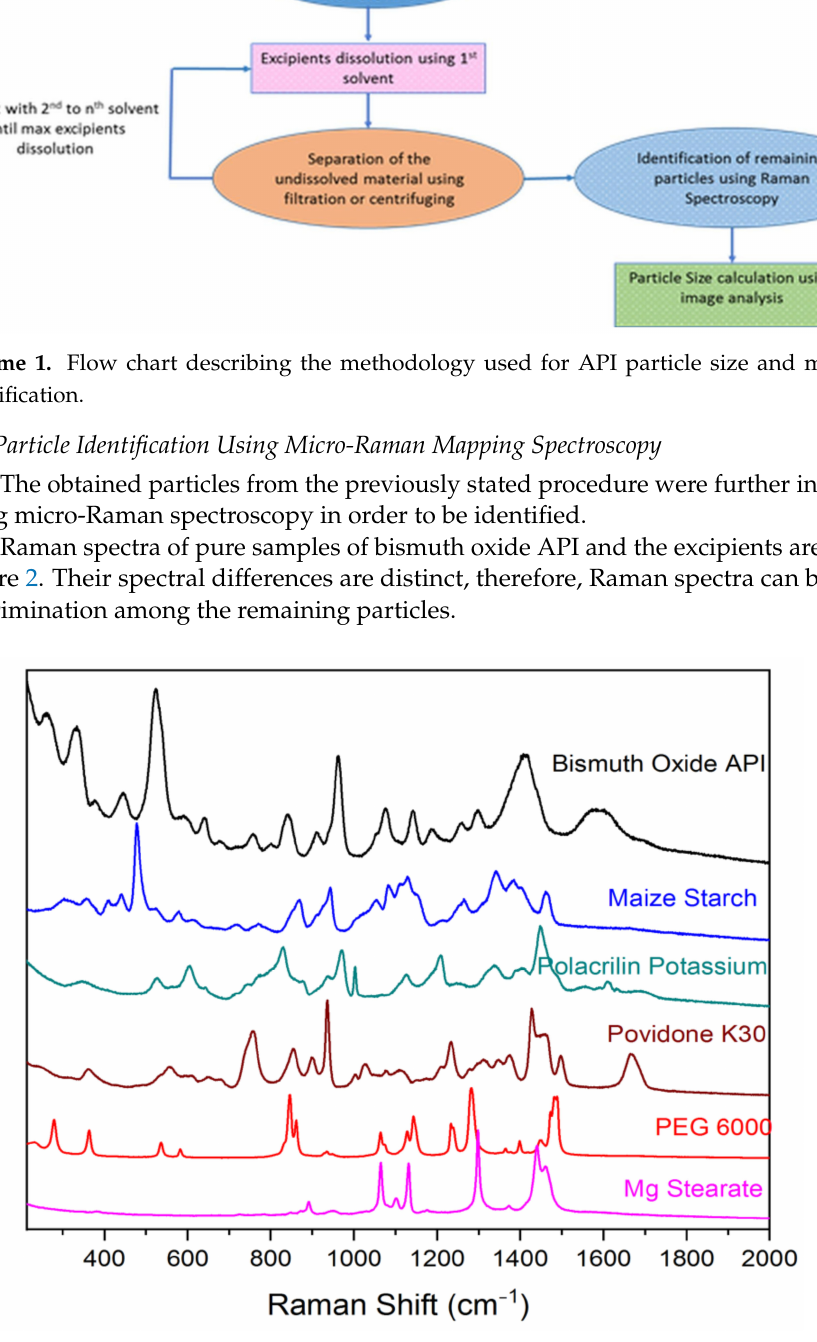
Figure 2. Raman spectra of bismuth oxide API, maize starch, polacrilin potassium, povidone K30, PEG 6000, and magnesium